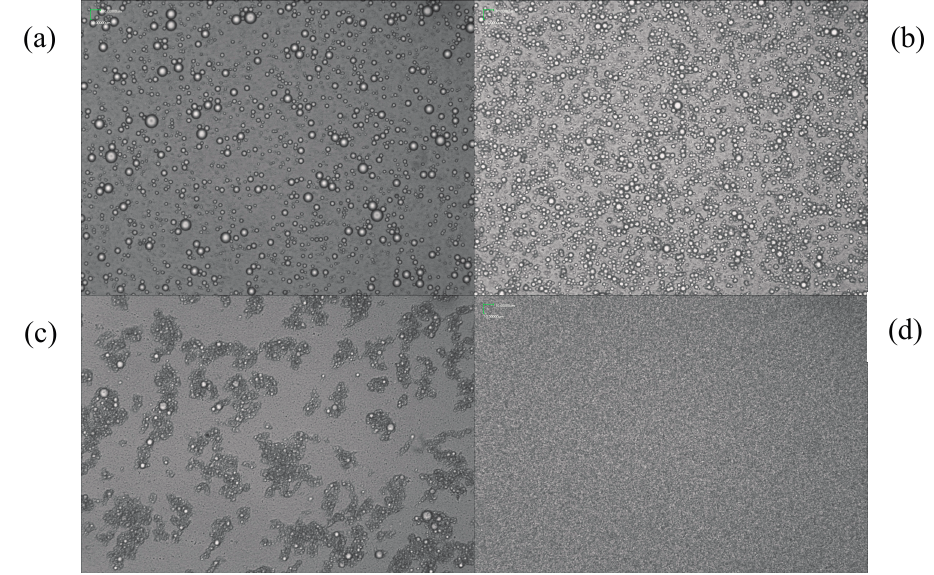
Figure 3. The microscopic image of the GBP nanoemulsion under different conditions: ( a ) 15 min, 75 °C, 20,000 r/min; ( b ) 10 min, 60 °C, 10,000 r/min; ( c ) 5 min, 45 °C, 10,000 r/min; ( d ) 12 min, 60 °C, 17,000 r/min (a, b, c, d